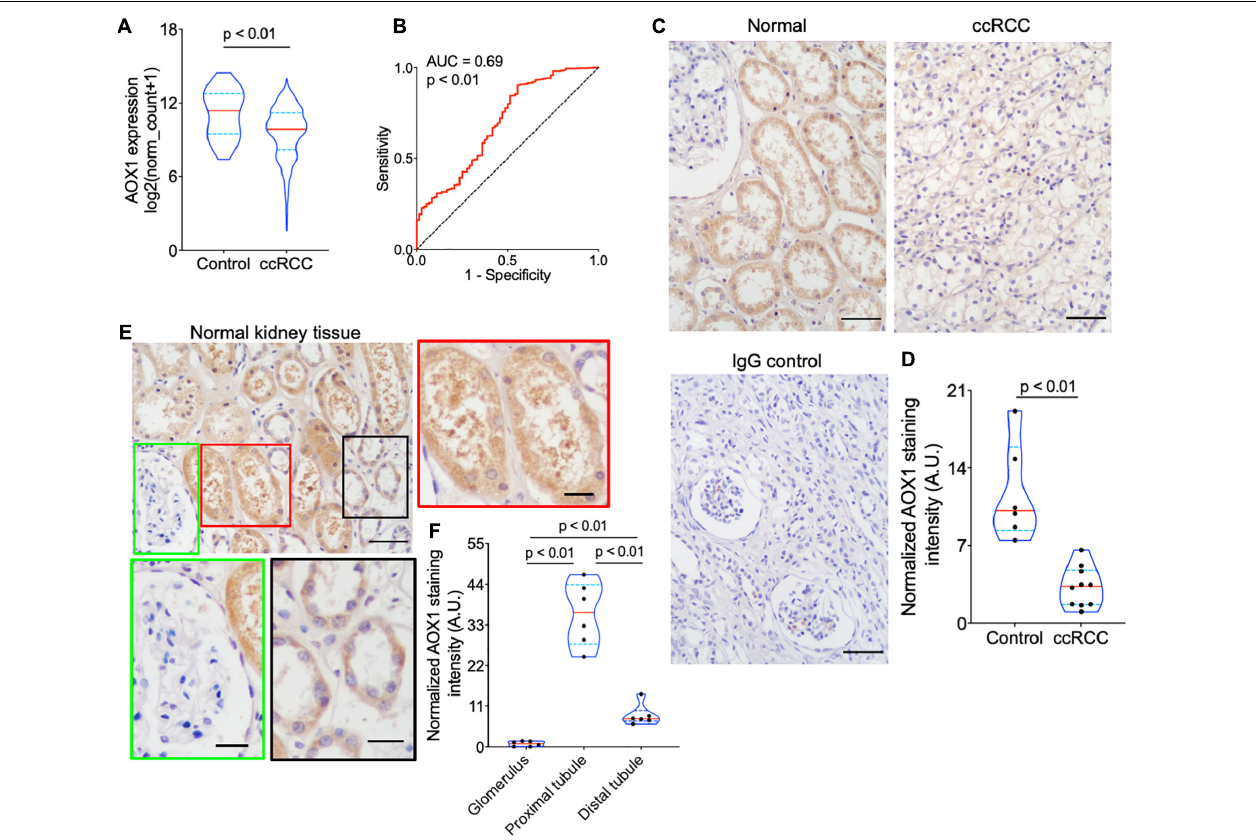
FIGURE 4 | Validation of AOX1 gene dysregulation in clear cell renal cell carcinoma (ccRCC). (A) Violin plot showing significantly lower AOX1 expression in ccRCC tissues compared with normal control kidney tissues in The Cancer Genome Atlas Kidney Renal Clear Cell Carcinoma (TCGA-KIRC) dataset. n = 72 and n = 533 for control and ccRCC, respectively. (B) Receiver operating characteristic (ROC) curve showing the predictive value of AOX1 expression for ccRCC patients. AUC, area under the curve. (C) Representative images of AOX1 immunohistochemical staining in normal kidney tissues (control) and ccRCC tissues. Scale bar is 50 µ m. (D) Violin plot for quantification of AOX1 staining intensity in panel (C) showing significantly lower AOX1 intensity in ccRCC tissues compared with normal kidney tissues (control). n = 6 and n = 10 for control and ccRCC, respectively. (E) Representative images of AOX1 immunochemical staining in normal kidney tissues demonstrating AOX1 expression in proximal tubules (left panel) and distal tubules (right panel). Scale bar is 50 µ m in upper left panel and 20 µ m in other panels. (F) Violin plot for quantification of AOX1 staining intensity in panel (E) shows the strongest AOX1 staining in proximal tubules. n = 6 for each group.